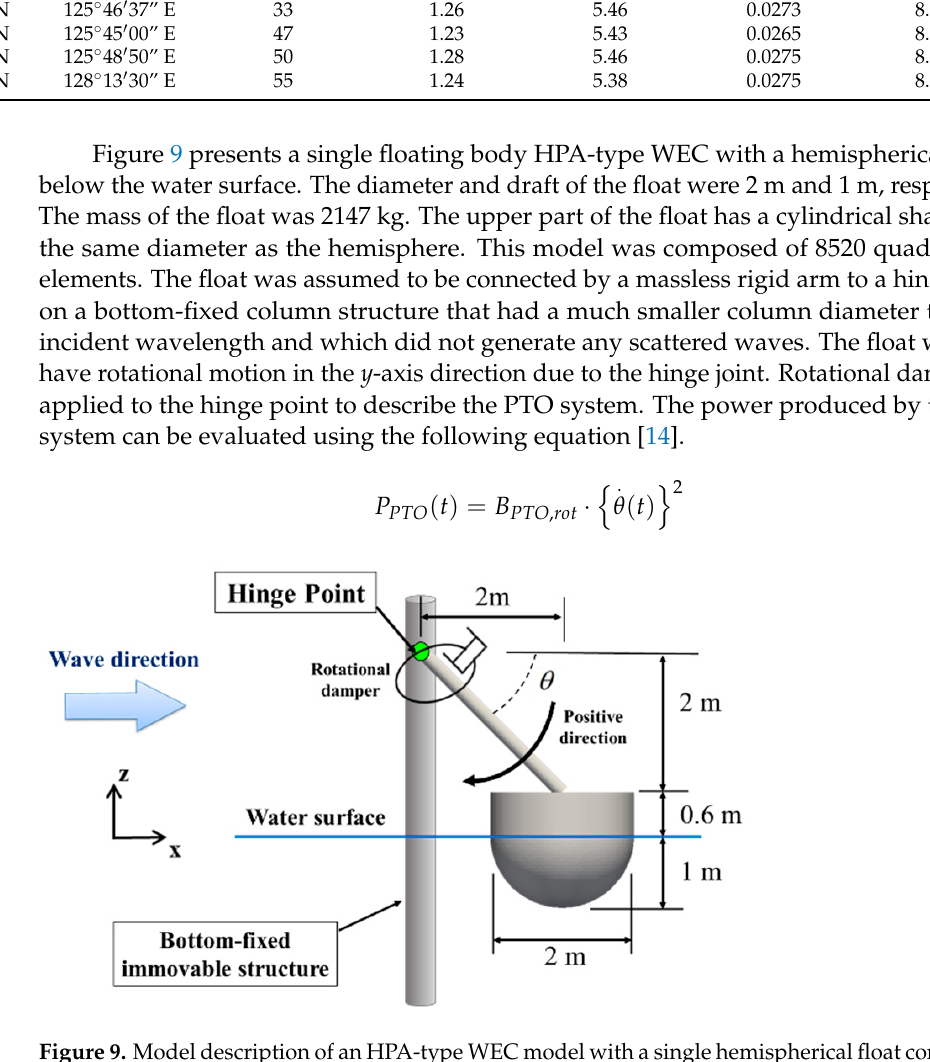
to a hinge strained to a hinge point.